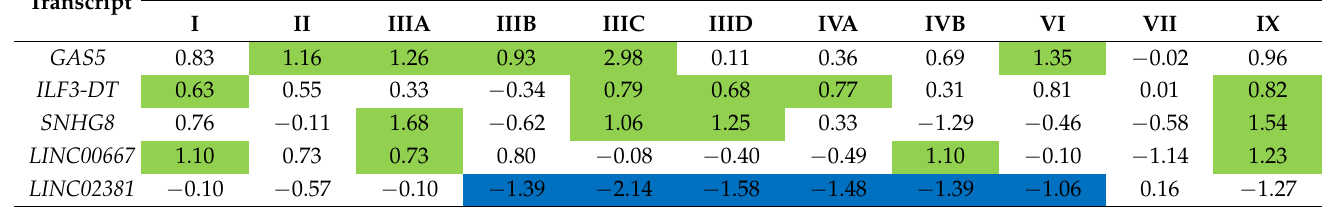
Table 2. Genes encoding lncRNAs whose expression is significantly changed in at least four MPS types relative to the control cells. Changes in expression (transcripts’ levels) of particular genes in MPS types are depicted, indicating log 2 fold change (FC) relative to control cells; up-regulation is marked in green while down-regulation in marked in blue; non-statistically significant differences are not colored.